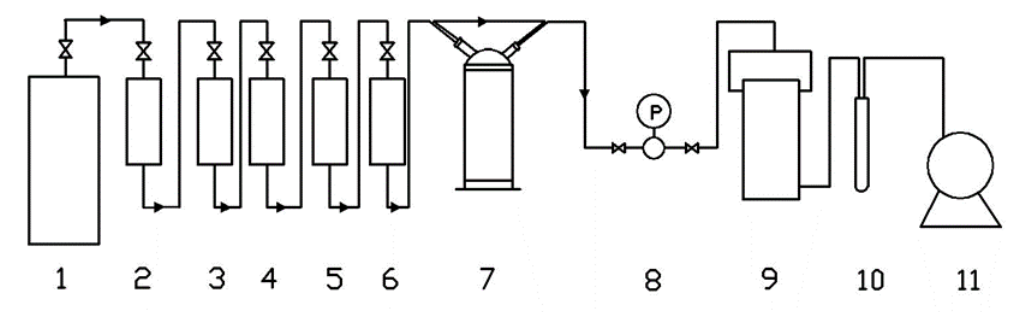
Figure 8. Process flow chart of ammonia synthesis catalyst performance evaluation unit. 1. liquid